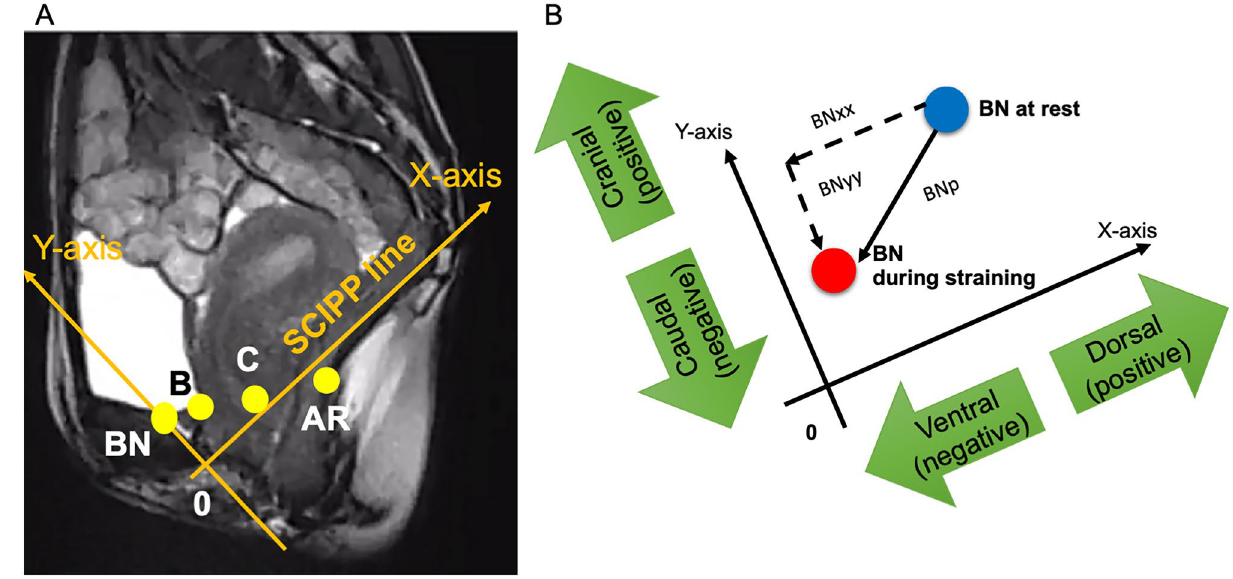
Figure 3. Methods to calculate positions and mobility of pelvic organs on dynamic magnetic resonance imaging. ( A ) Shows the selected coordinate positions of pelvic organs in the present study, while ( B ) shows how to calculate pelvic organ mobility, for example mobility of BN. As shown in ( B ), if BN moves ventrally in parallel with the X-axis, BNxx takes a negative value, while if BN moves dorsally, BNxx takes a positive value. Likewise, if BN moves caudally in parallel with the Y-axis, BNyy takes a negative value, while if BN moves cranially, BNyy takes a positive value. AR, anorectal angle; B, most dependent position of the bladder; BN, bladder neck; C, uterine cervix; xx, distance in x-direction; yy, distance in y-direction; X-axis corresponds to the sacrococcygeal inferior pubic point (SCIPP) line and Y-axis corresponds to a perpendicular line to X-axis at the origin (0, the inferior margin of the pubic